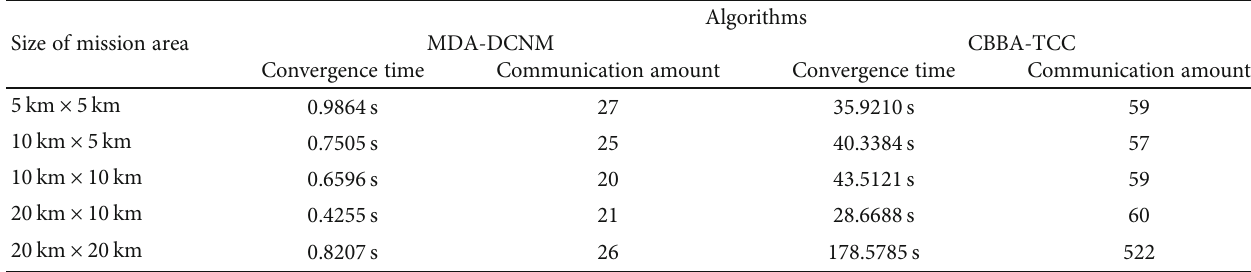
Table 8: Convergence performance of two algorithms under di ff erent mission sizes.